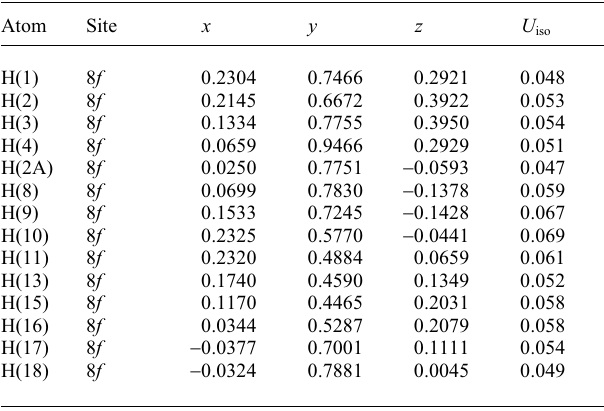
Table 2. Atomic coordinates and displacement parameters (in Å 2 )